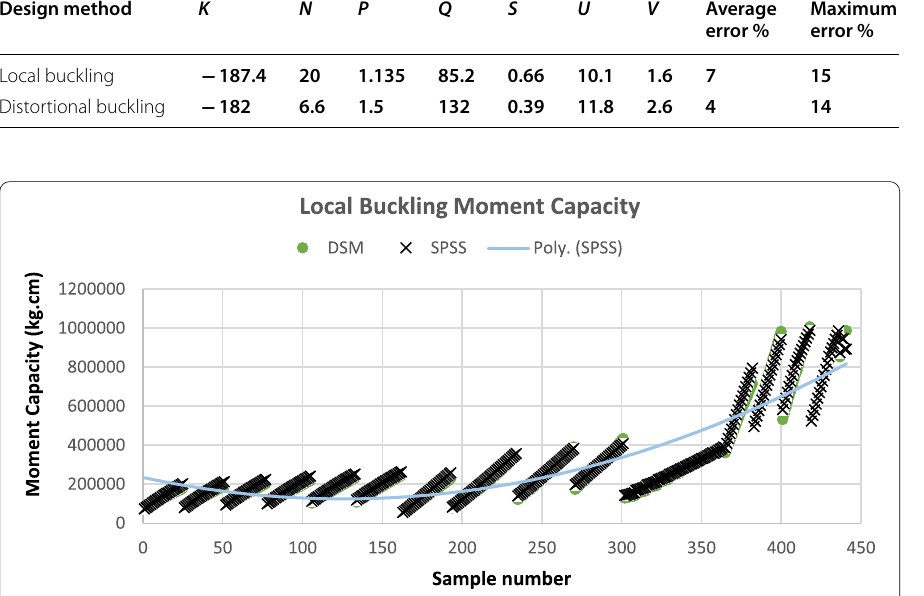
Fig. 2 Local buckling moment capacity calculated using DSM and proposal equation for the 441 studied